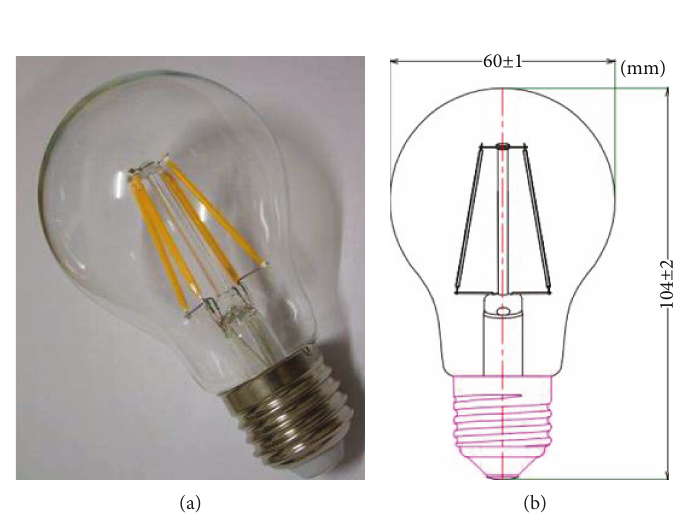
Figure 1: (a) The A60 LED fi lament lamp and (b) its structure parameters.